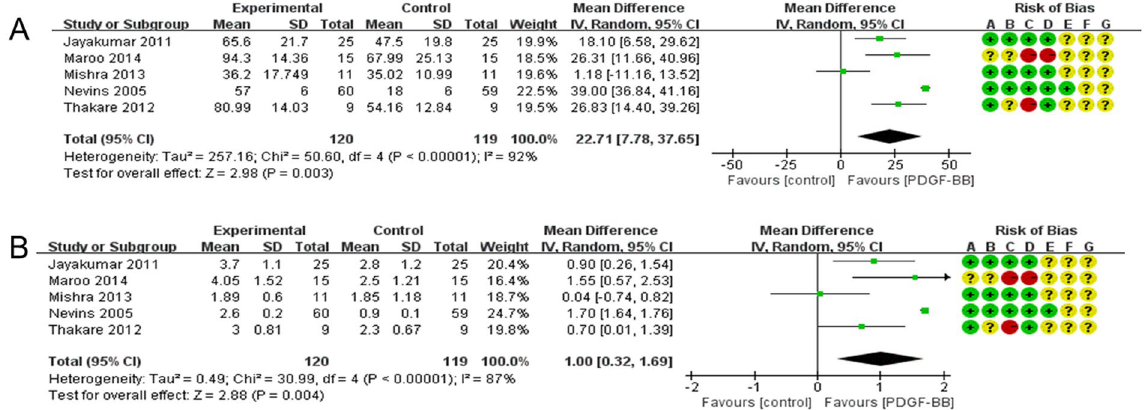
Figure 3. ( A ) Forest plot of comparison: 0.3 mg/ml PDGF-BB groups was compared with control groups among patients with osseous defects, outcome: BF%. ( B ) Forest plot of comparison: 0.3 mg/ml PDGF-BB was compared with control groups among patients with osseous defects, outcome: